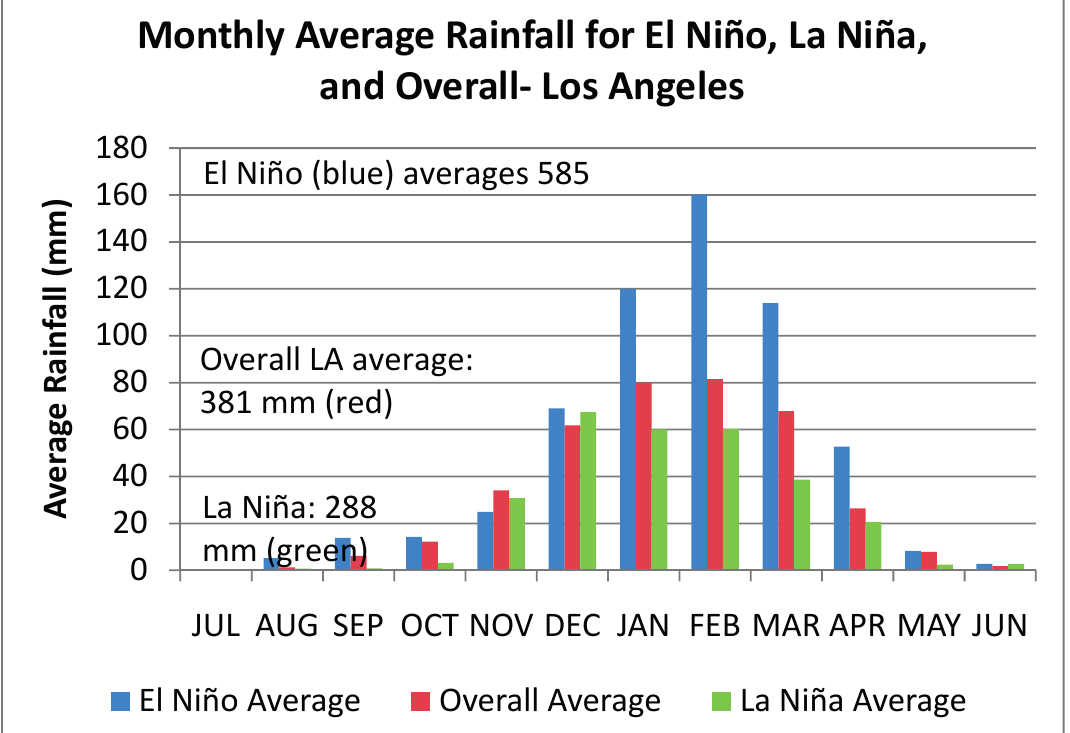
Figure 4. During El Nino events, Los Angeles receives more than twice the rainfall than during La Nina events. Note also that rainfall peaks later during El Niño events than La Niña